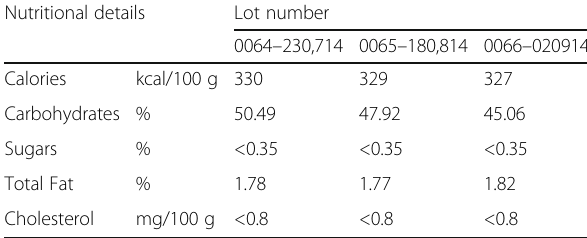
Table 2 Nutritional details of three lots of